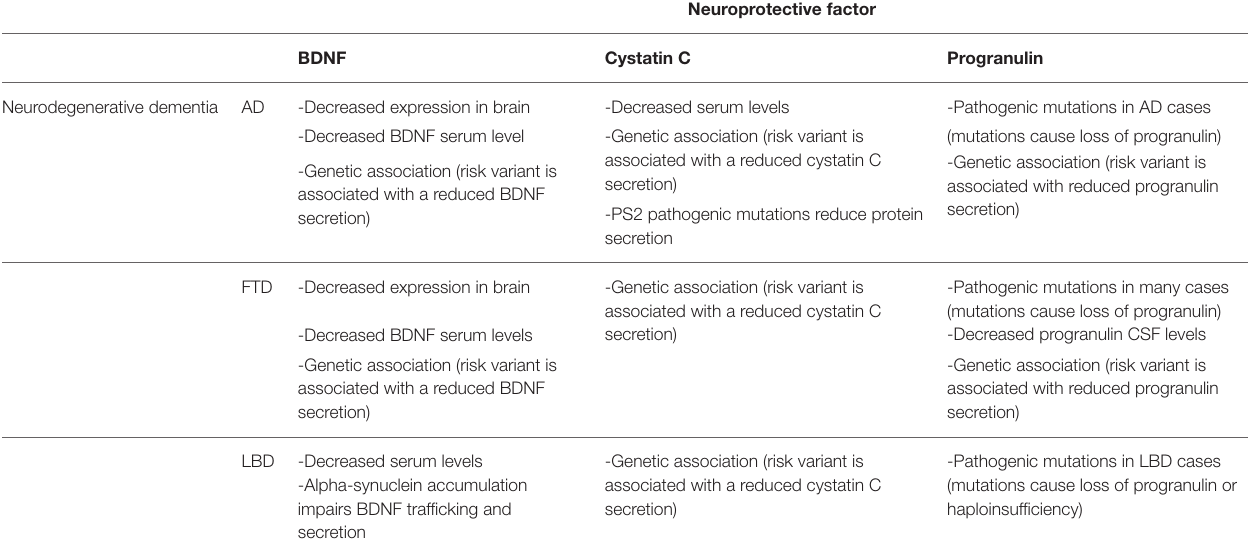
TABLE 1 | Summary of human studies demonstrating a loss of BDNF, cystatin C and progranulin as a common theme in AD, FTD, and